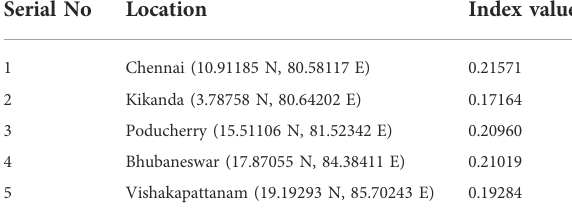
TABLE 6 Table showing the performance analysis of fi ve